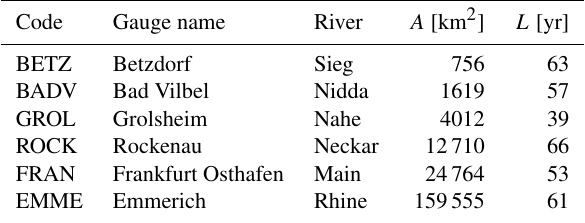
Table 2. List of gauging stations (full name, used abbreviation (code), associated river system, and length L of the time series) used for the validation of the hydrological model for selected historical flood events sorted by the upstream catchment size ( A